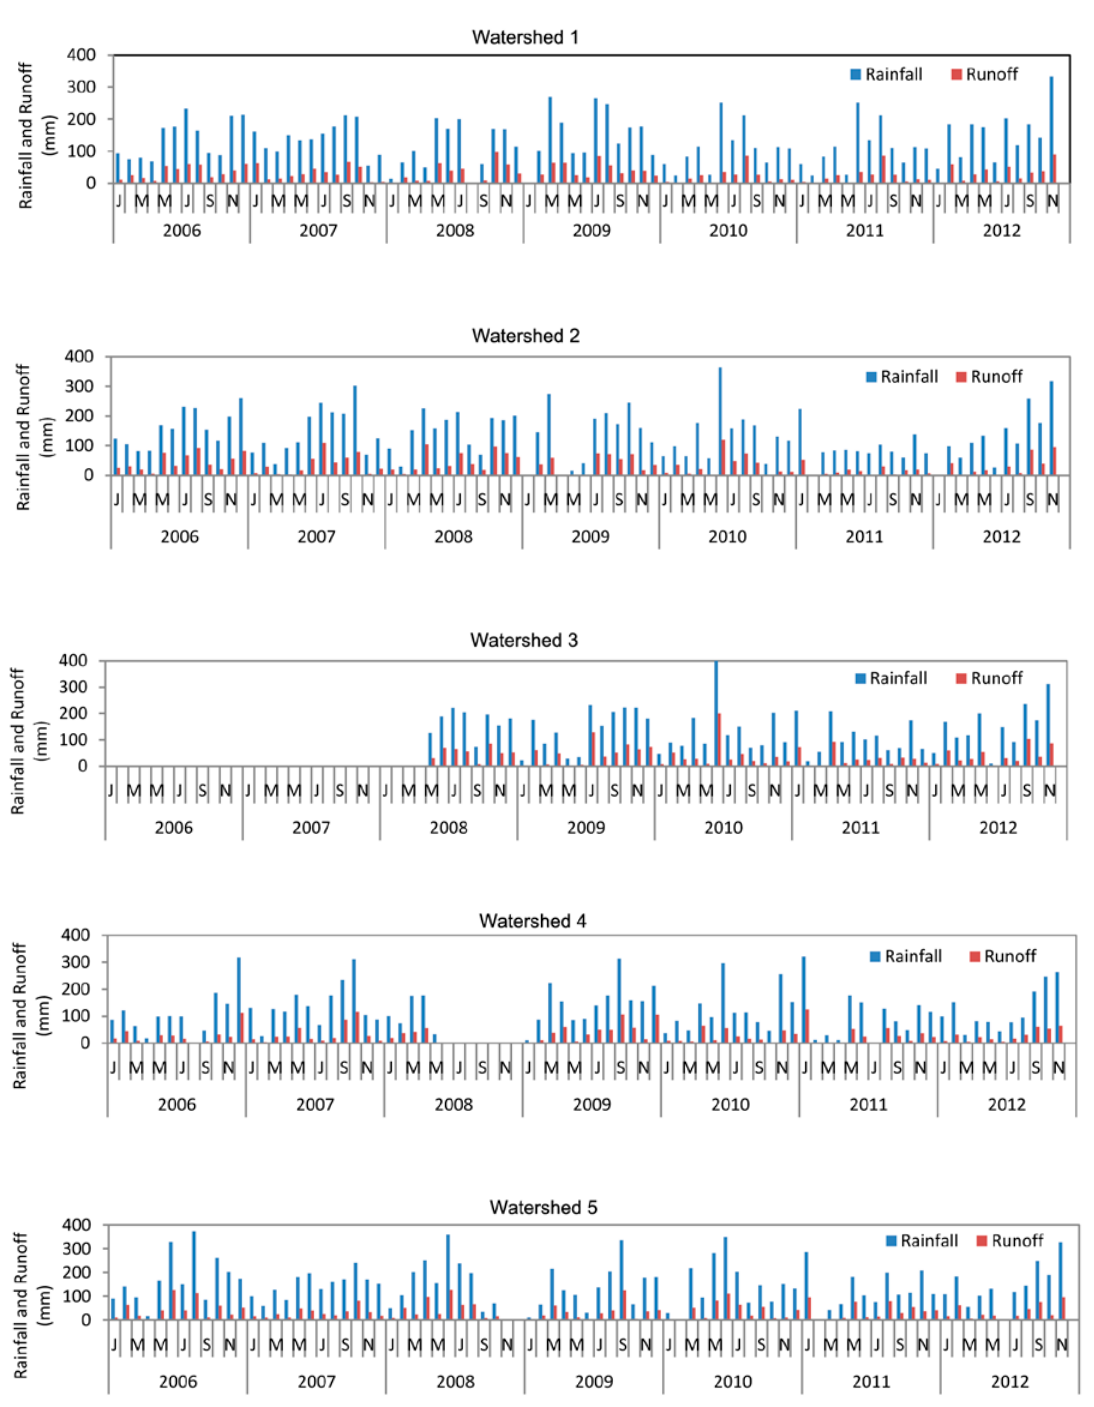
Fig. 4. Monthly rainfall and runoff of watershed